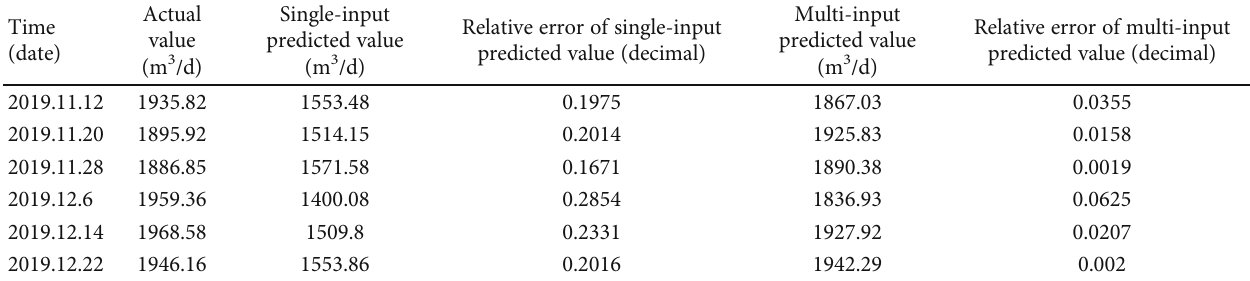
Table 2: Comparison table of real value and predicted value of INJ-01 well.